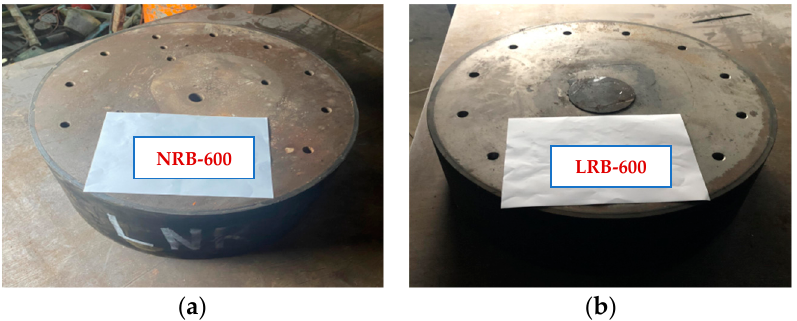
Figure 1. Test specimen of the two rubber bearings: ( a ) NRB‑600 specimen; ( b ) LRB‑600 specimen.